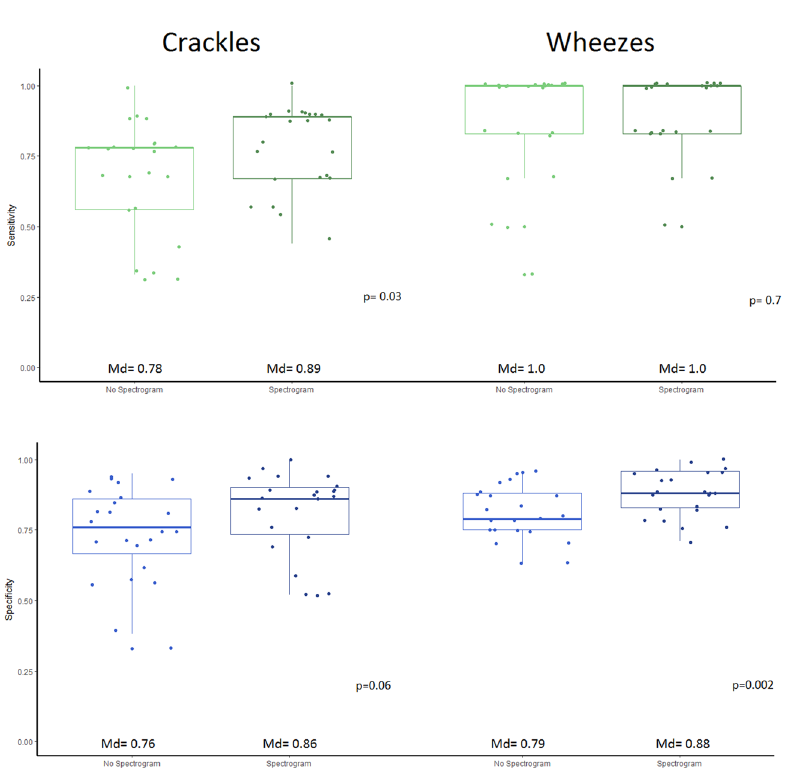
Figure 6. Box and whiskers diagrams showing the change in sensitivity and specificity of the students classifying wheezes and crackles with and without spectrograms. The answers of the experts were considered as the reference standard. P values shown were obtained from the test of difference between means using paired Wilcoxon signed rank test with continuity correction. Md =